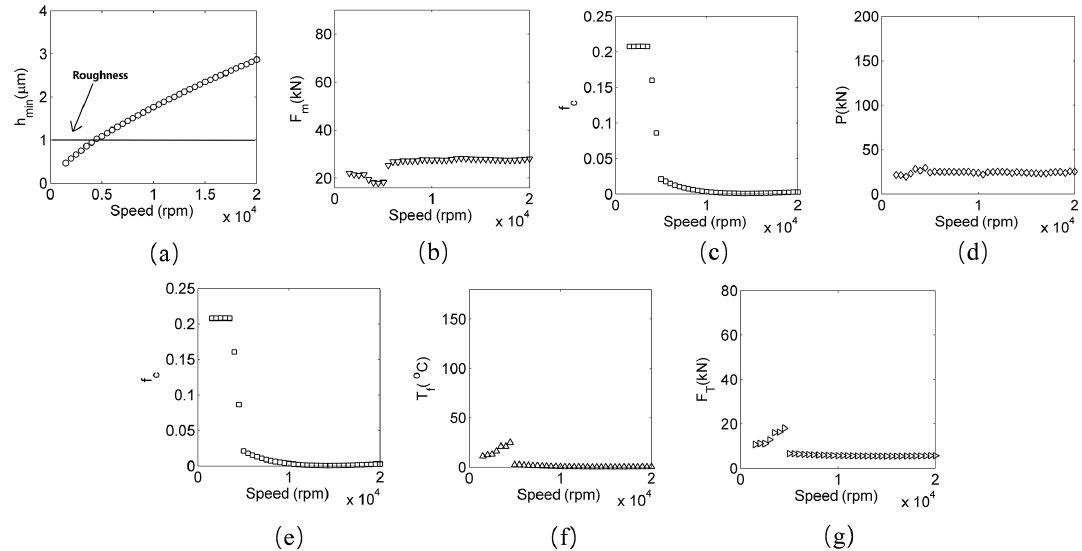
Figure 12. Response at the torque load of 2500Nm and the lubricating oil viscosity of 30cPs. (a) Minimum thickness of the lubricating oil; (b) meshing force; (c) friction coefficient; (d) pressure of the tooth surface; (e) friction force; (f) flash temperature; (g) thermal stress.